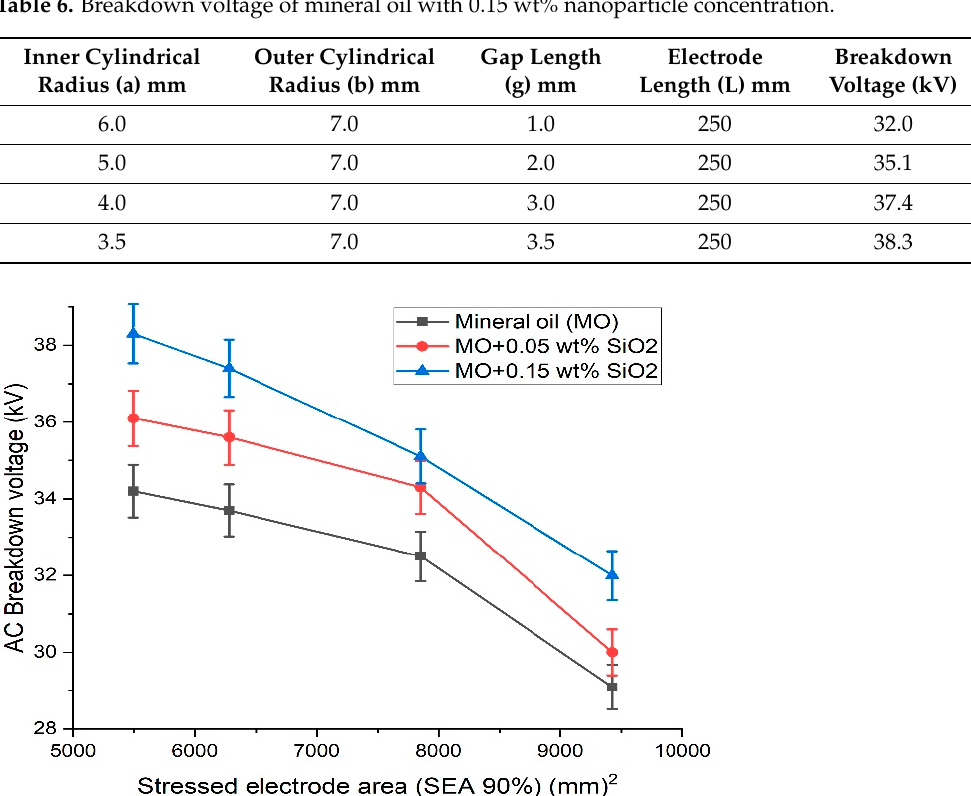
Figure 7. Graph showing the variation of breakdown voltage of mineral oil and its nanofluids with SEA (90%).